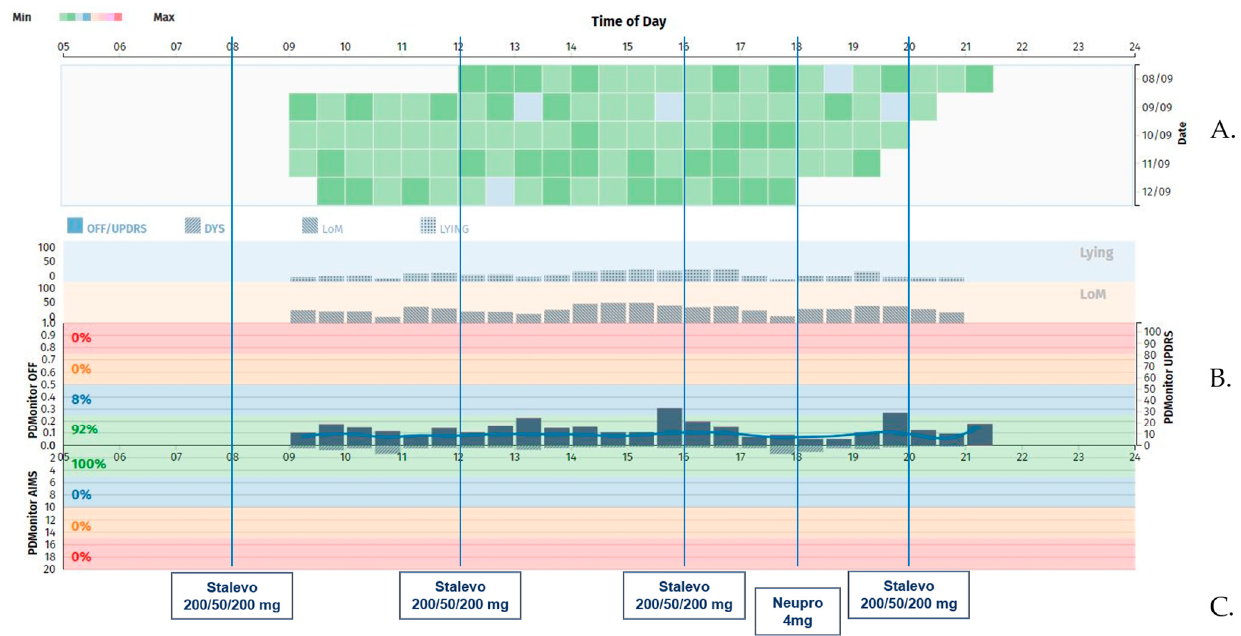
Figure 1. PDMonitor ® OFF/dyskinesia chart for a well-controlled patient with slight fluctuations: ( A ) severity of a symptom for a 30 min interval using a heat map displaying the symptom severity; ( B ) chart with the average symptom intensity for any time of day (bars above the x-axis represent OFF while below the presence of dyskinesia); ( C ) the medication the patient receives.